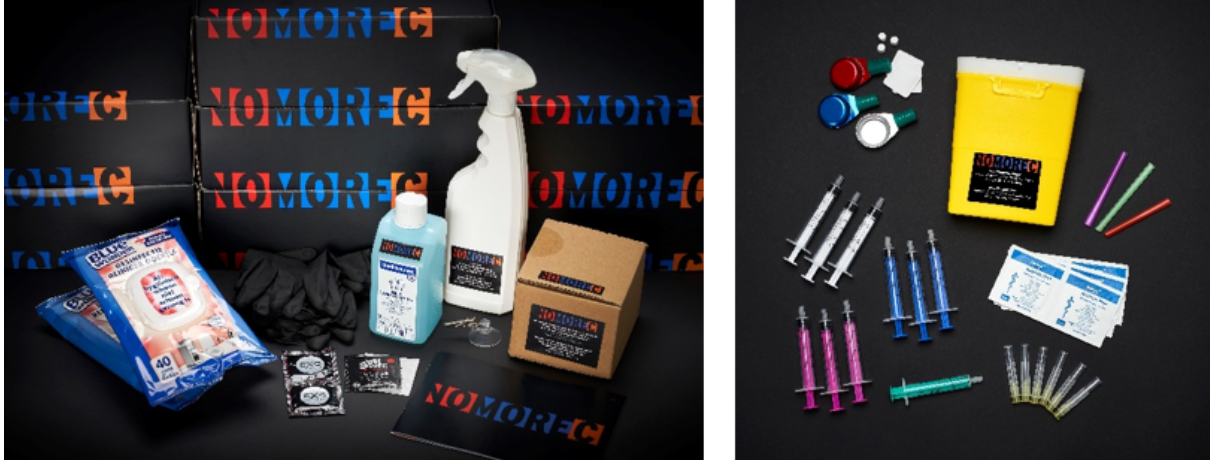
Figure 6. NoMoreC Toolbox (left) and contents of safe drug use box (right). The NoMoreC Toolbox contains a spray bottle, disinfectant for hands, hydrogen peroxide cleaning wipes, gloves, condoms, a hand washing instruction card, a cardboard safe drug use box and booklet with tips and tricks to reduce hepatitis C transmission risk. The safe drug use box is a small cardboard box that is included in the toolbox. It contains snorting straws, a sharps container, syringes, needles, mixing cups, and alcohol wipes. A sticker with the text “Never share drug use equipment. Pick your own color.” is stuck on the